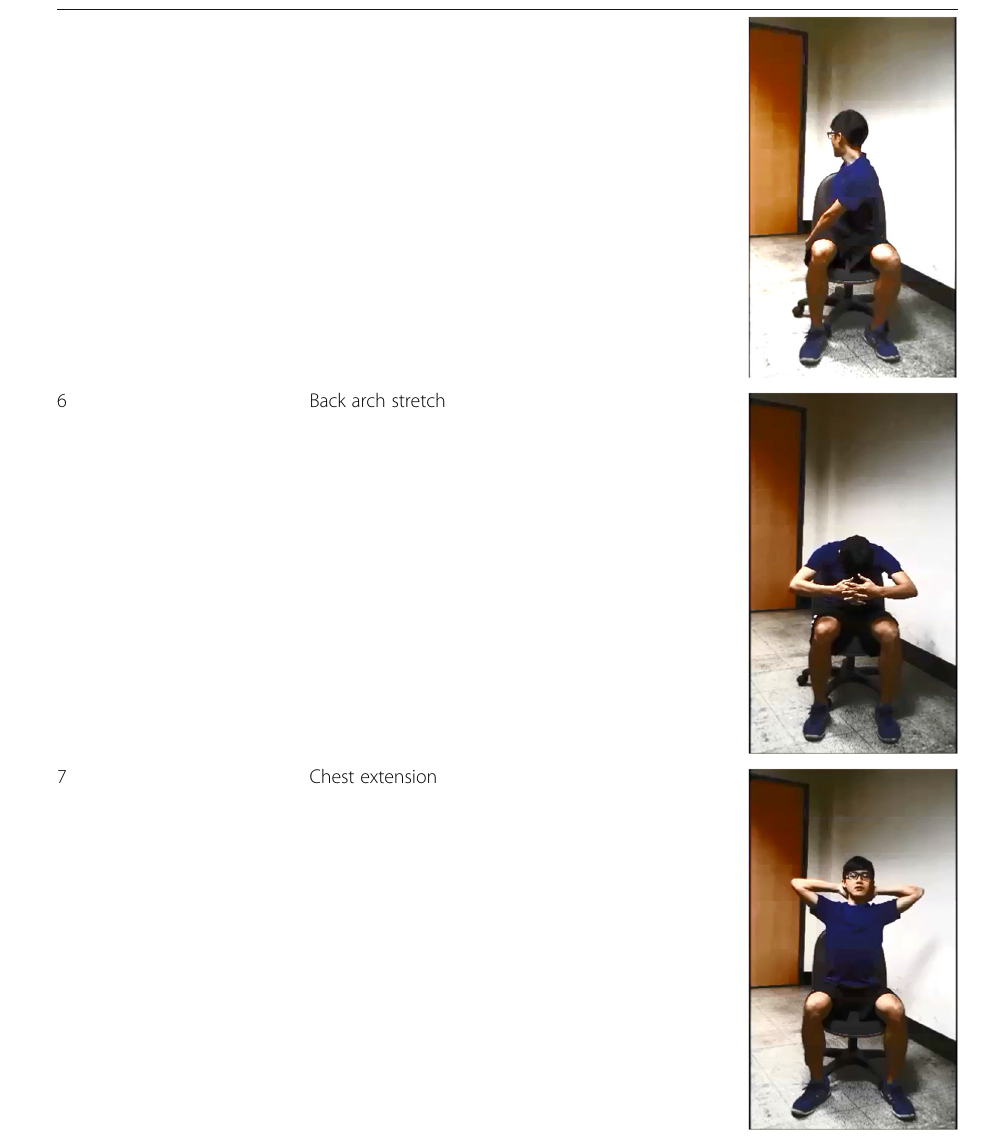
Table 4 Seven positions of the cooldown exercise (Continued)